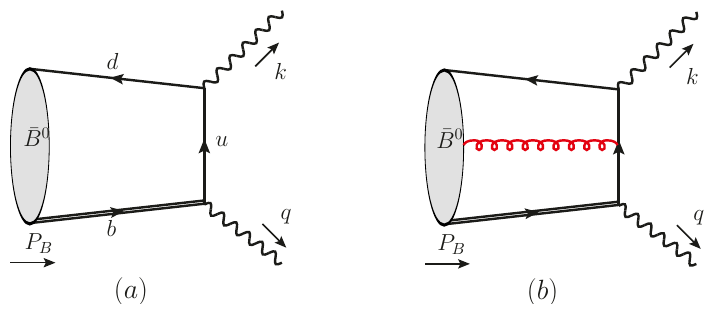
Figure 1 . Diagram of the correlation function (2.1): (a) at leading order (two-body B-meson DA), (b) the soft-gluon contribution (three-body B-meson DA). Wavy lines with four-momentum k and q represent the dipion interpolating and weak b ! u currents,